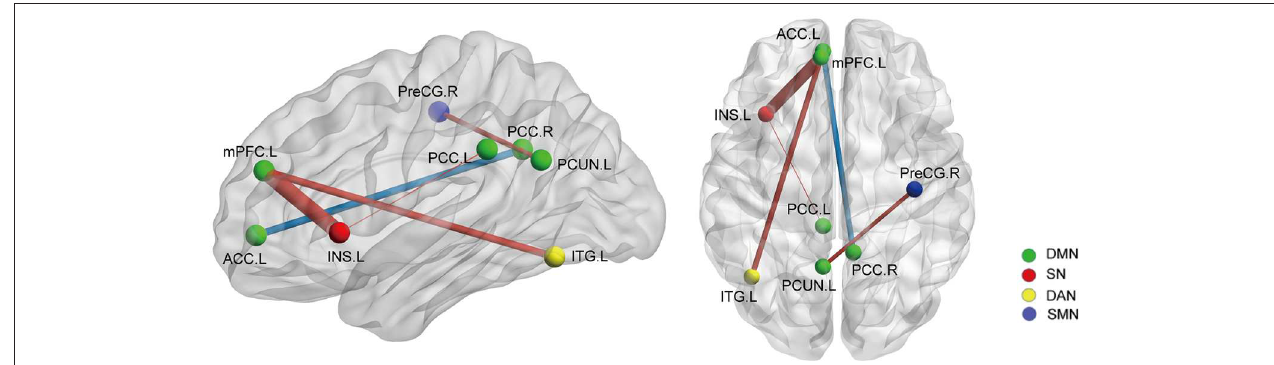
FIGURE 1 | The whole network functional connectivity differences between the AS patients and HCs ( p < 0.05, FDR corrected). Ball color indicates different brain networks. Red/blue line indicates the FC strengths in the AS cohort that were higher/lower (more/less positive correlation) than those in the HCs. The line width indicates the degree of differences (wider line means larger difference). DMN: default mode network; SN: salience network; SMN: sensory/somatomotor network; DAN: dorsal attention network.